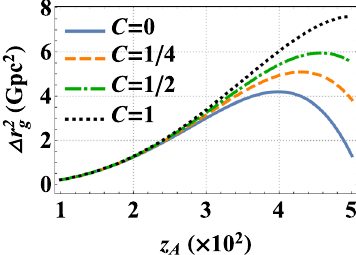
Fig. 3 High-order correction to the gravitational horizon radius. The parameter C is set to C = 0 (blue solid curve), C = 1 / 4 (orange dashed curve), C = 1 / 2 (green dashed and dotted curve), and C = 1 (dark dotted curve),